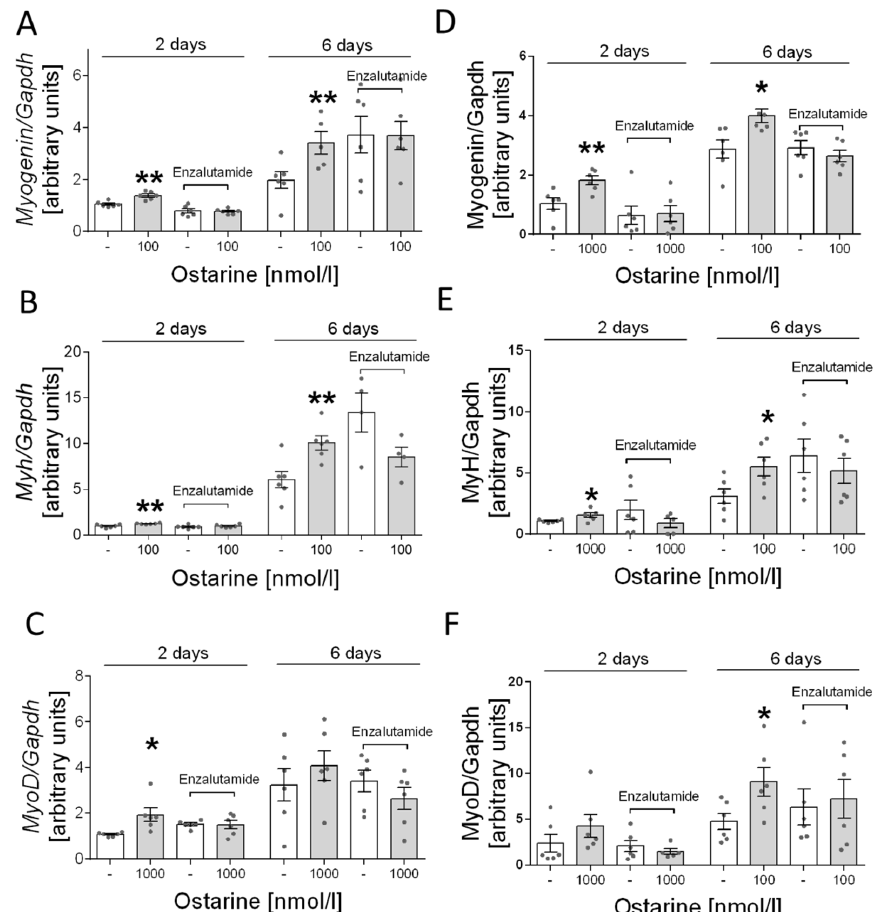
Figure 6. Effect of pharmacological blocking of AR and ostarine on myogenin , myh , and myoD mRNA after 2 and 6 days of differentiation initiation in ( A – C ) L6 cells and ( D – F ) C2C12 cells. Statistically significant differences are represented as * p < 0.05 and ** p < 0.01 versus corresponding control using unpaired Student’s t -test (two-tailed distribution) or Mann–Whitney U test.